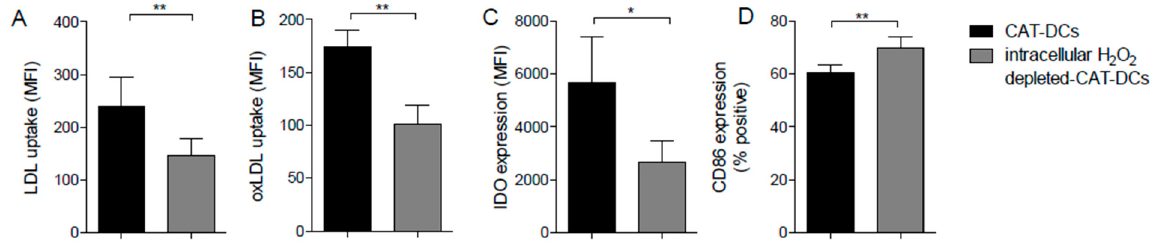
Figure 7. Intracellular H 2 O 2 -levels and LDL-uptake affect each other. ( A , B ) Measurement of relative ox-/LDL uptake by fluorometric detection of phRodo-LDL and dil-oxLDL in CAT-DCs with intracellular depleted H 2 O 2 by MitoQ in comparison to untreated CAT-DCs ( n = 5). ( C , D ) Flow-cytometric measurements of IDO- ( C ) and CD86 expression ( D ) in intracellular-H 2 O 2 -depleted CAT-DCs ( n = 5). Statistical analysis was performed with a paired two-tail Student’s t -test. (* p < 0.05, ** p < 0.01).